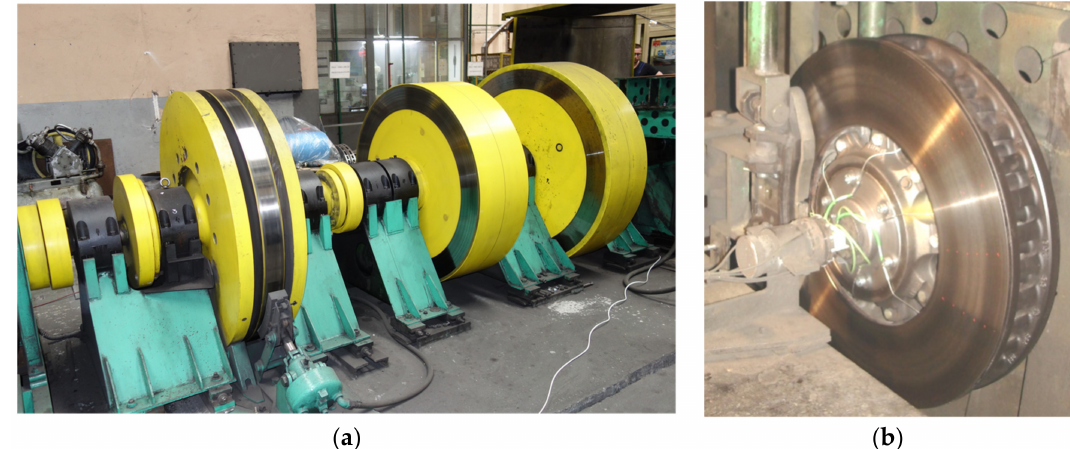
Figure 3. Stand for testing railway disc brakes: ( a ) driving part of the brake stand with rotating masses, ( b ) brake disc type 610 × 110 mm mounted on the brake stand.